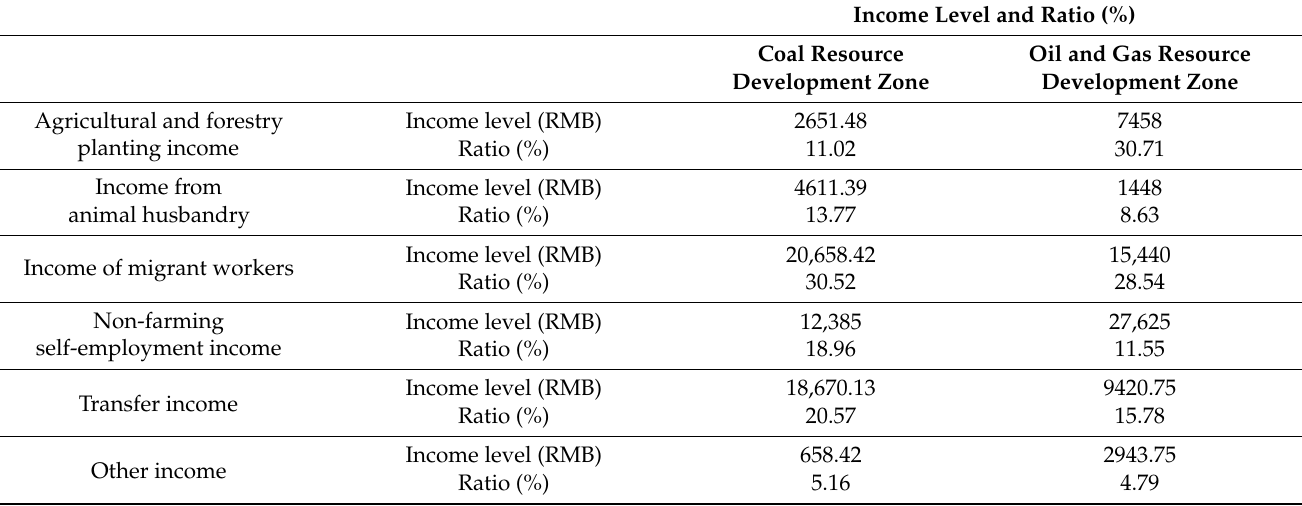
Table 5. Level and composition of income in different energy development